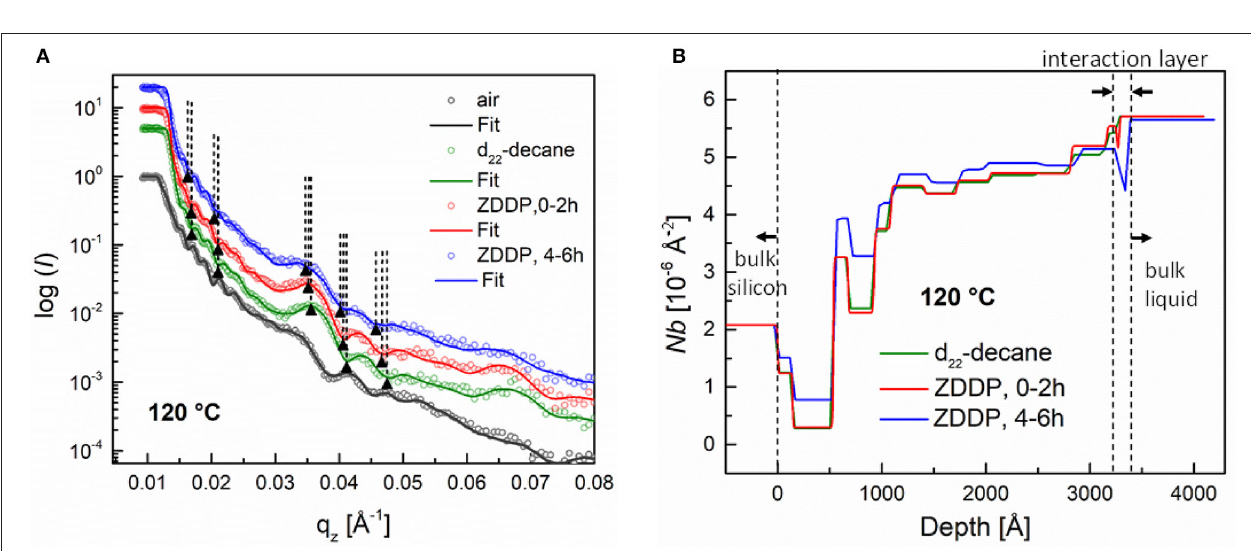
FIGURE 9 | (A) Neutron reflectivity profiles (dots) and best fits (continuous lines) for an a-C:H coating measured in air, in deuterated decane and finally in the presence of a 1 wt.% ZDDP solution for various exposure times at 120 ◦ C, (B) SLD profiles extracted from fitted curve. The SLD profile for an a-C:H coating in air is omitted for the sake of